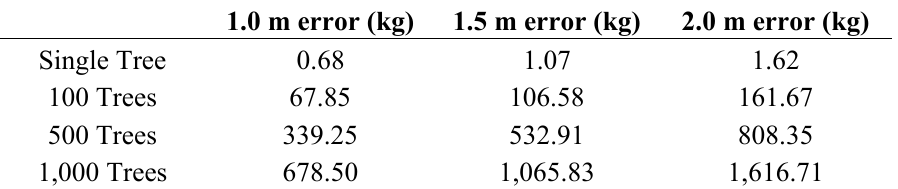
Table 17. TAGB error estimate based on LiDAR height